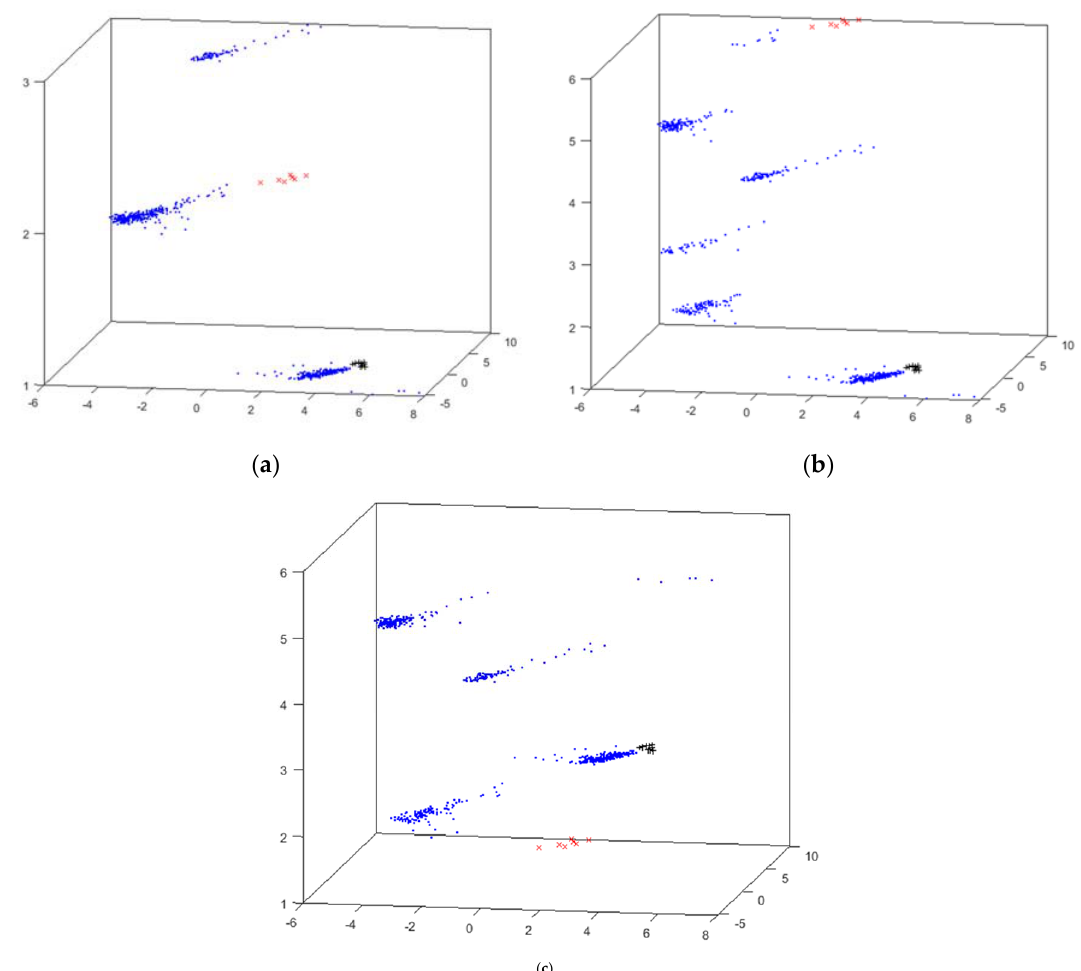
Figure 9. HUEP visualizations generated by CMDS–Seuclidean and different clustering parameters for the cyclone dataset. ( a ) HUEP: CMDS–Seuclidean+ k ‐ means ( k = 3 and Correlation). ( b ) HUEP: CMDS–Seuclidean +k ‐ means ( k = 6 and Correlation). ( c ) HUEP: CMDS–Seuclidean+hierarchical clustering ( k = 6, Cityblock, and weighted).